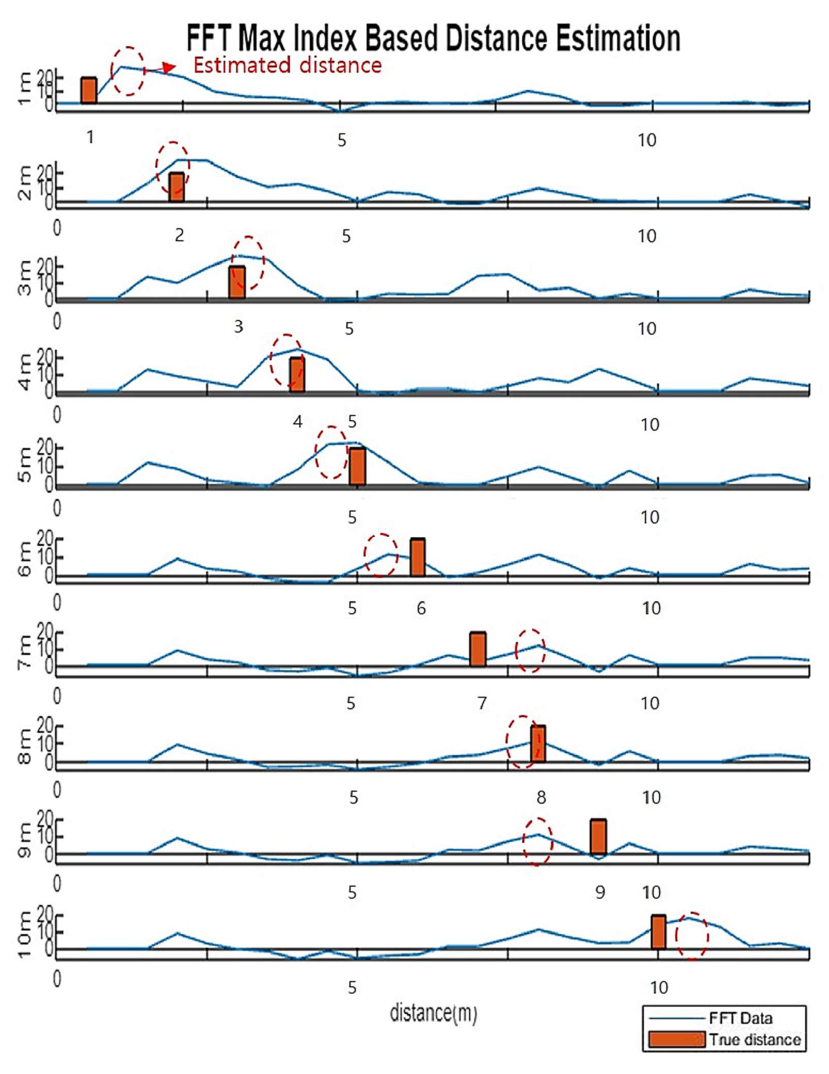
Figure 4. Distance estimation graph of conventional scheme.